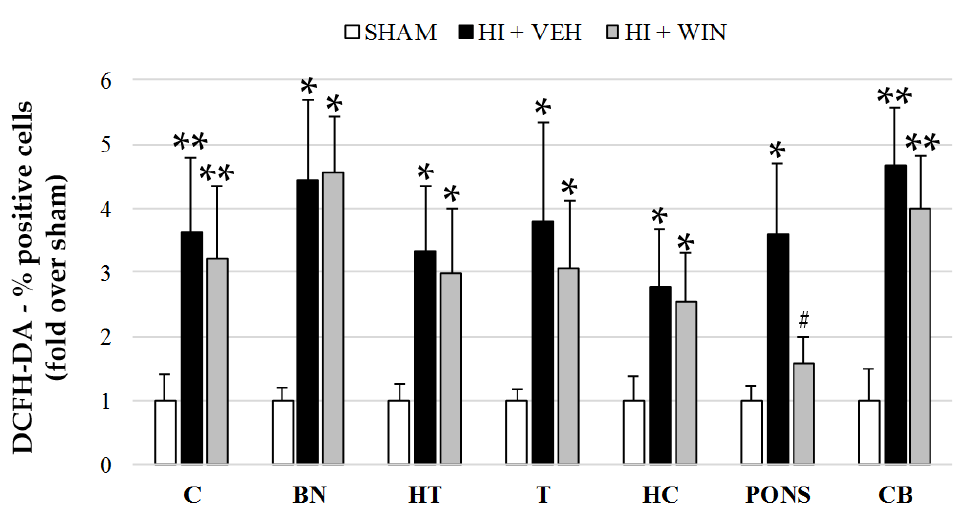
Figure 1. Quantification of ROS in different brain regions evaluated after sham or HI (and vehicle or WIN treatment) in fetal lambs. Samples from both hemispheres were analyzed in triplicate by flow cytometry ( n = 6) for each animal and condition. Values given as the mean ± SD. (*) ANOVA p < 0.05 vs. sham and HI+WIN; (**) ANOVA p < 0.01 vs. sham and HI+WIN ; (#) ANOVA p < 0.05 vs. HI+VEH. Sham, n = 6; HI+VEH, n = 6; HI+WIN, n = 6. (C: cortex; BN: basal nuclei; HT: hypothalamus; T: thalamus; HC: hippocampus; CB: cerebellum).